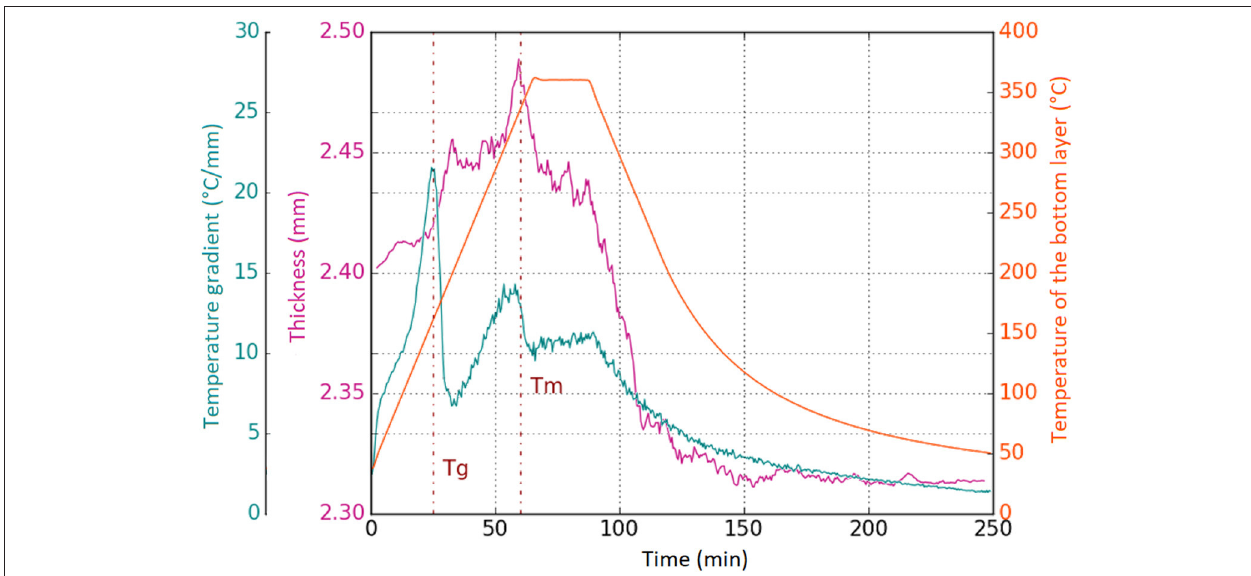
FIGURE 5 | Results of average temperature gradient and thickness against time.